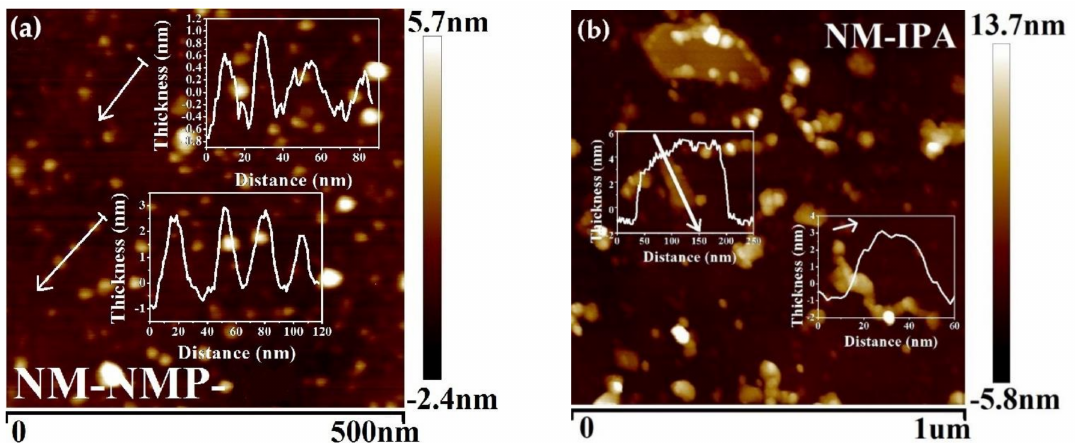
Figure 3. Atomic force microscopy (AFM) images of products exfoliated from NM in NMP ( a ) and in IPA ( b ). The insets show the height profiles along with the arrows. AFM images and height profile confirming the thickness of <6 nm.